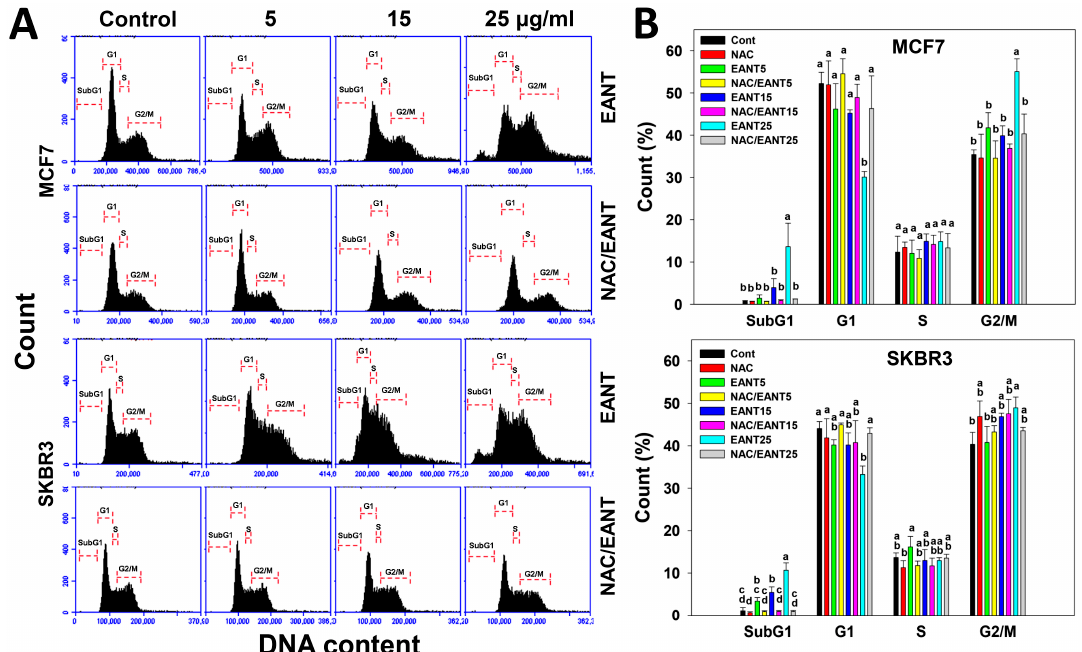
Figure 2. Cell cycle change after EANT treatment. ( A , B ) Cell cycle distribution patterns and statistics. Without or with NAC pretreatment, breast cancer cells (MCF7 and SKBR3) were treated with 0 (control with DMSO only), 5, 15, and 25 µ g / mL of EANT for 24 h, i.e., EANT vs. NAC / EANT. For each